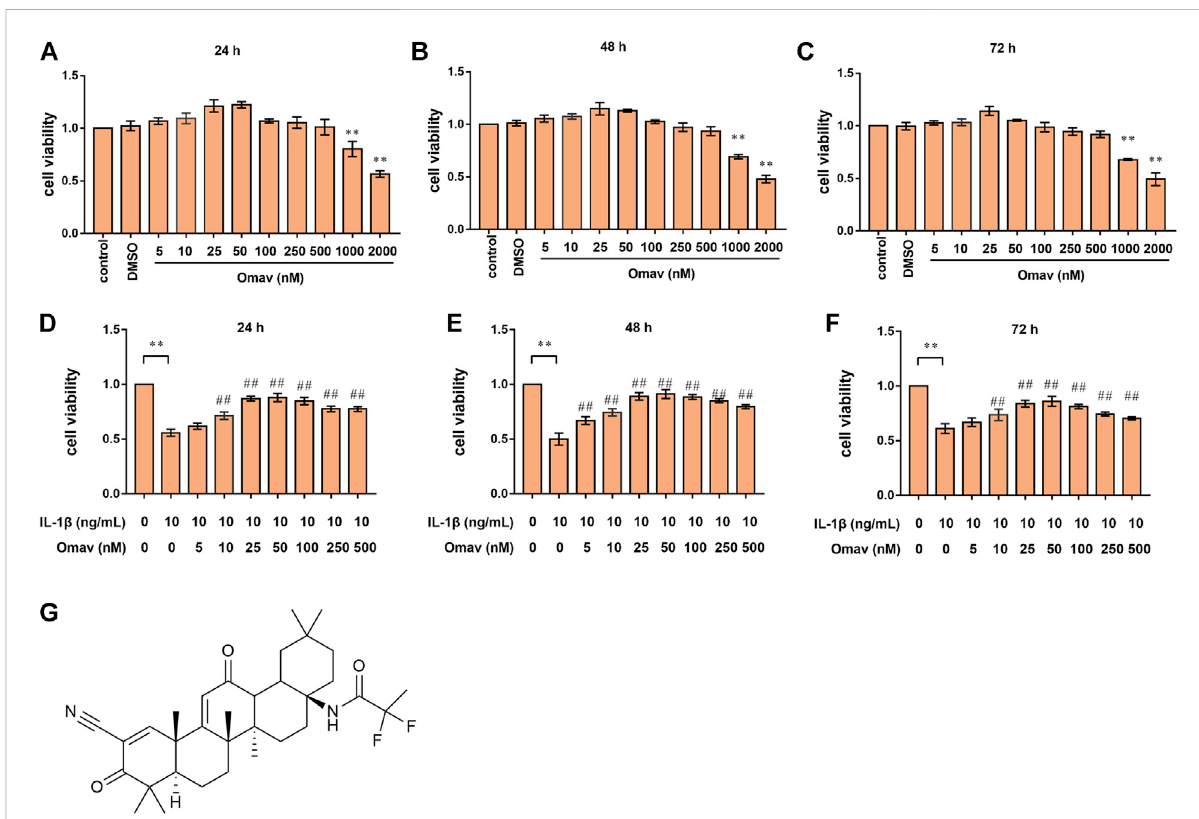
FIGURE 1 Omaveloxolone improved the viability of chondrocytes treated with IL-1 β in vitro . Cell viability of chondrocytes treated with different concentrations of omaveloxolone (5, 10, 25, 50, 100, 250, 500, 1000, and 2000 nM) at 24 h (A) , 48 h (B) and 72 h (C) . Effects of different concentrationsofomaveloxolone (5,10,25, 50, 100, 250, and500 nM) ontheviabilityofchondrocytesexposedto 10 ng/mLIL-1 β for 24 h (D) , 48 h (E) and72 h (F) . (G) The structural formulaofomaveloxolone. * p < 0.05and** p < 0.01 versusthecontrolgroup. # p < 0.05 and ## p < 0.01